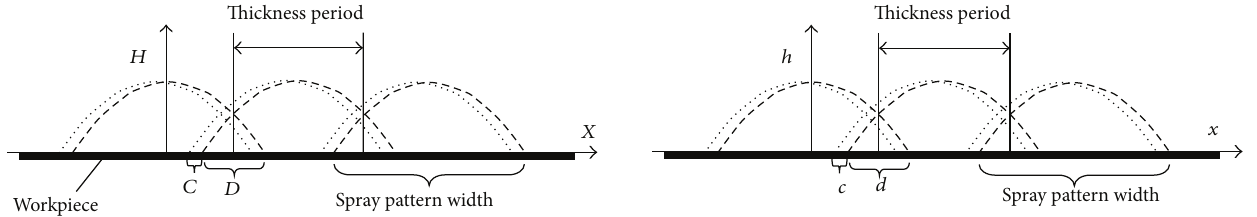
Figure 4: Model of interlacing painting. Figure 5: Dimensionless interlacing